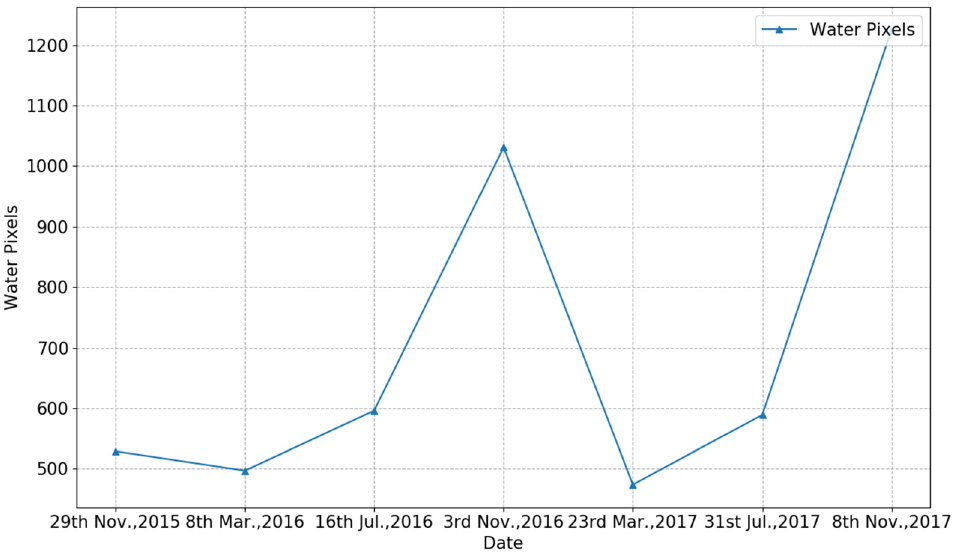
Figure 12. Long-term river monitoring curve based on river segmentation results. The curve shows the amount of river pixels within the satellite imagery among different time.